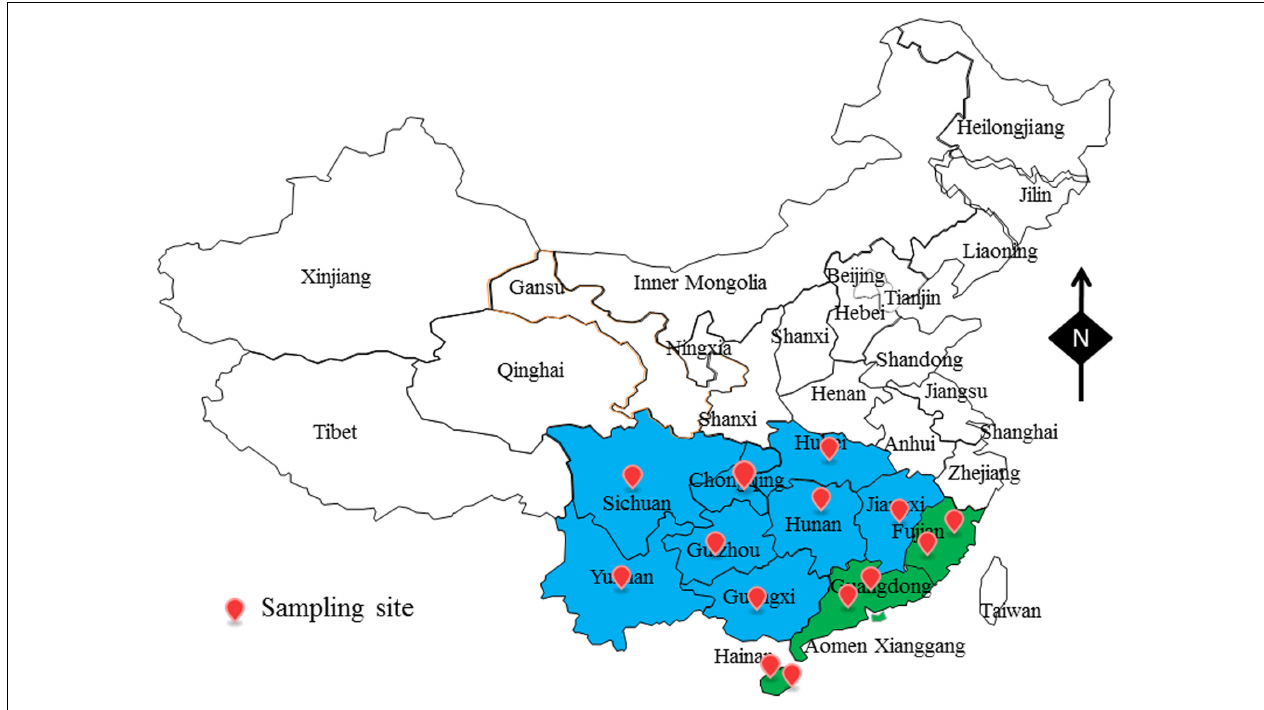
FIGURE 1 | The sampling site of foods sample in South